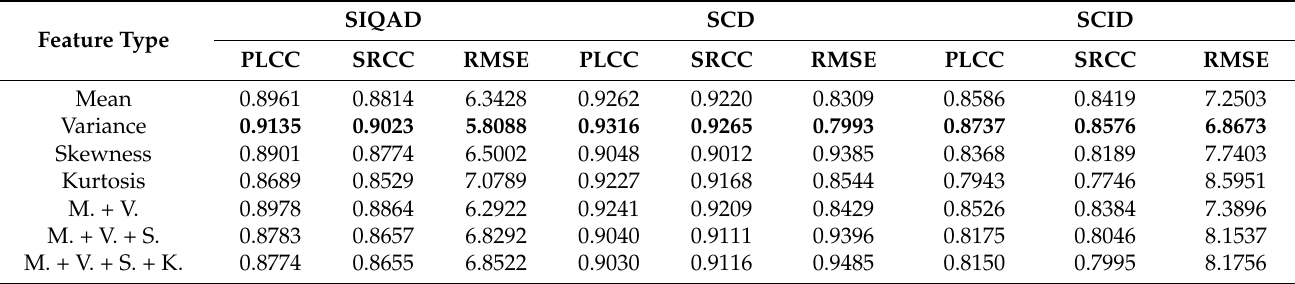
Table 10. Experimental results of prediction performance with different feature types.